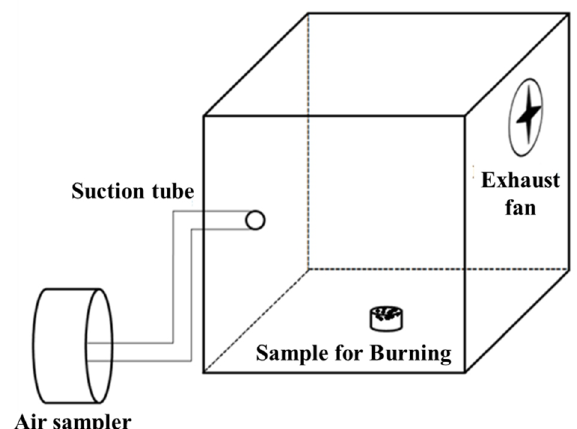
Fig. 2 A closed chamber (0.5x0.5x0.5 m 3 ) equipped with the exhaust fan and UC Davis (USA) portable air sampler